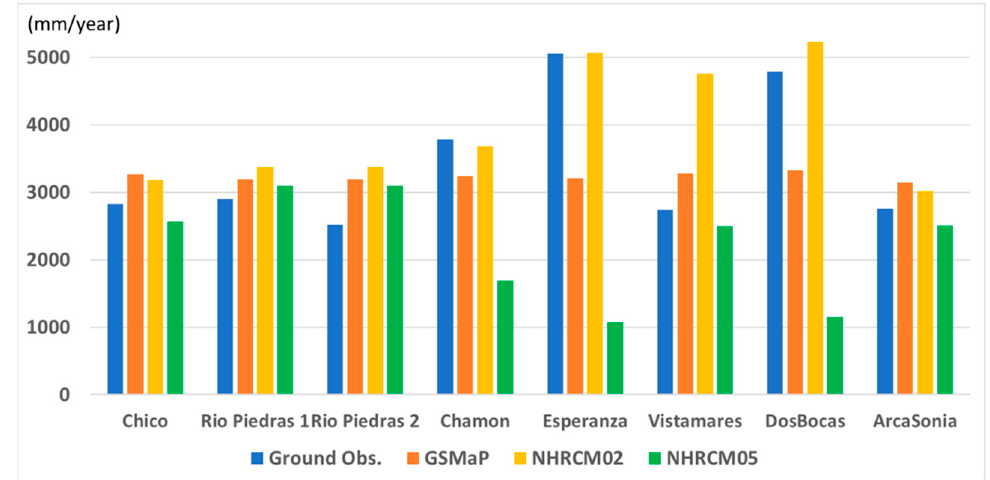
Figure 7. Comparison of annual precipitation at eight stations in upper Chagres River Basin among four datasets: ground observations, GSMaP, NHRCM02, and NHRCM05.